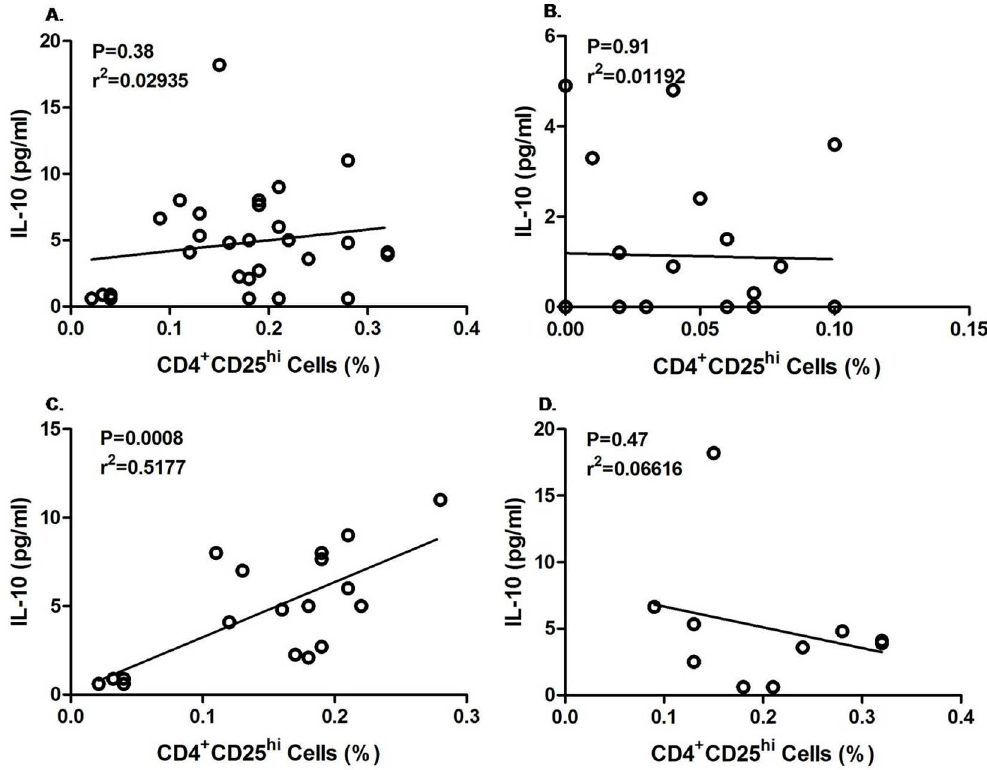
Fig 5. Correlation between Tregs (CD4+CD25 hi ) with IL-10 level in enrolled CFA+ve and CFA–vemothers during follow up. Each dot represents value from a single subject while the solid lines representthe regression lines. Valuesof p and r derive from Pearson’s correlationanalysis. A. enrolledCFA+ve mothers (n = 28, p = 0.38, r 2 = 0.029) and B. EnrolledCFA–ve mother (n = 21, p = 0.91, r 2 = 0.012). C. EnrolledCFA +ve mothers who remained CFA+ve duringfollow up (n = 18, p = 0.008, r 2 = 0.518). D. EnrolledCFA+ve mothers who became CFA-ve during follow up (n = 10, p = 0.47, r 2 = 0.066)